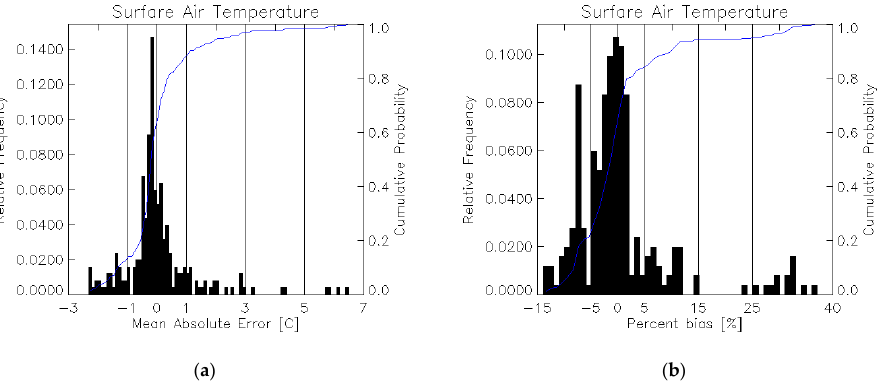
Figure C1 . Distribution describing the relative and cumulative distributions of the mean absolute error ( a ) and percent bias ( b ) for 252 station years of Global Surface Summary of the Day (GSOD) daily man temperature compared to surface air temperature from a regional climate model for CORDEX-Africa. Both the error and the bias are centered around 0 indicating no systematic deviations.